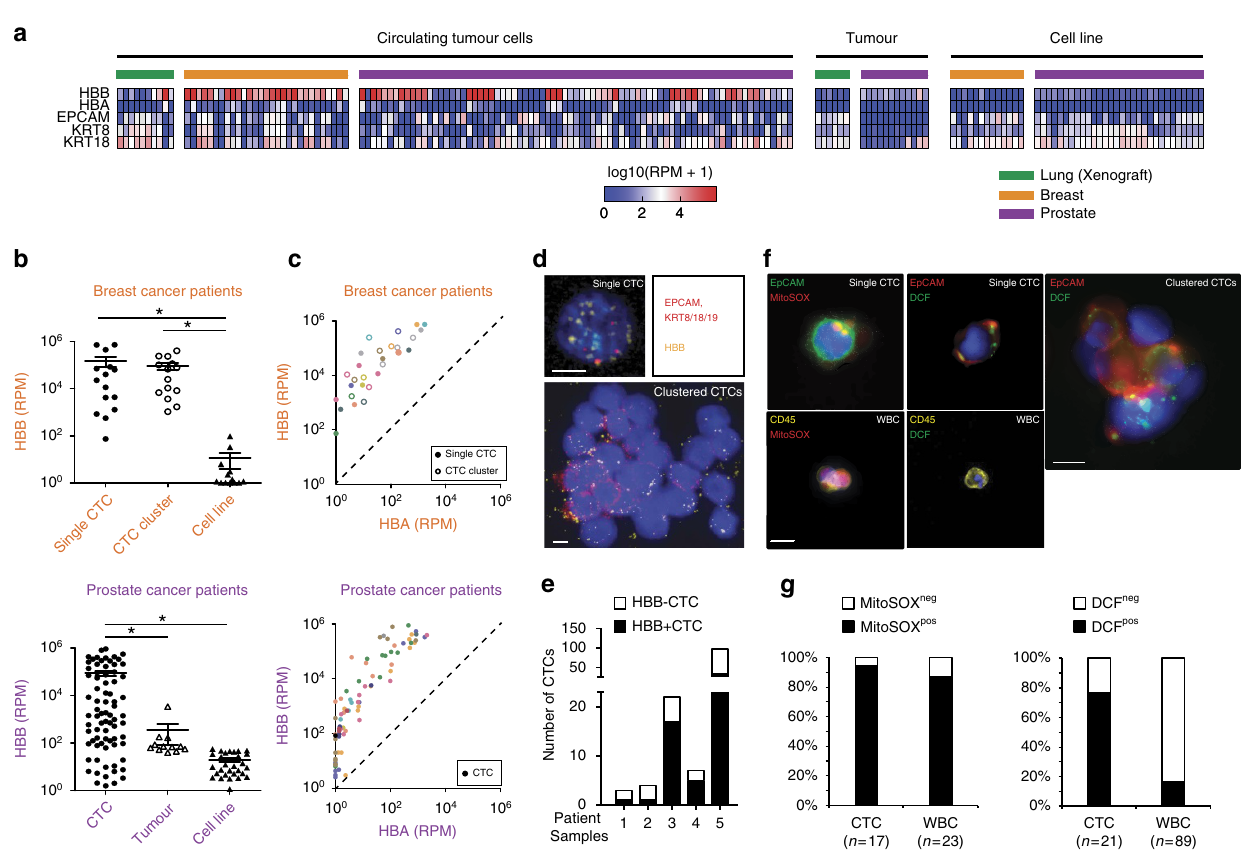
Figure 1 | Elevated expression of HBB is detected in circulating tumour cells. ( a ) Heat map showing relative expression of haemoglobin genes ( HBB and HBA ) and epithelial lineage genes ( EPCAM, KRT8 and KRT18 ) in single CTCs and clustered CTCs (lung, n ¼ 10; breast, n ¼ 29 and prostate, n ¼ 77), primary tumour samples (lung, n ¼ 6; prostate, n ¼ 12), and established cancer cell lines (breast, n ¼ 13; prostate, n ¼ 4). Data are derived from single-cell RNA sequencing (see Methods). ( b ) Scatter plot showing increased expression of HBB in single CTCs or CTC-clusters isolated from clinical blood samples of patients with metastatic breast or prostate cancer, compared with single primary tumour cells and/or established cancer cell lines. Data are represented as mean ± s.e.m. *denotes P o 0.05 ( t -Test). ( c ) Scatter plot demonstrating the specific upregulation of HBB but not HBA in CTCs of breast and prostate cancer patients. Each colour represents a different patient. ( d ) Representative fluorescence images ( (cid:2) 40) of RNA- in situ hybridization of a single prostate CTC and a prostate CTC-cluster show expression of HBB (yellow dots), and the epithelial lineage markers, EPCAM and KRT8/18/19 . DNA is stained with 4 0 , 6 0 -diamidino-2-phenylindole (blue). Scale bar, 10 m m. ( e ) Quantitation of RNA- in situ signal defining HBB -negative and HBB -positive CTCs from a cohort of 5 patients with advanced prostate cancer. ( f ) Representative fluorescence images of DCF or MitoSOX staining of a single prostate CTCs or CTC-clusters. Prostate CTCs were identified by EpCAM staining, and white blood cells (WBCs) were identified by CD45 positivity. DNA is stained with DAPI. Scale bar, 10 m m. ( g ) Quantitation of fluorescent signal defining MitoSOX-positive and DCF-positive CTCs and WBCs from a cohort of 5 patients with advanced prostate cancer. The total number of cells analysed is